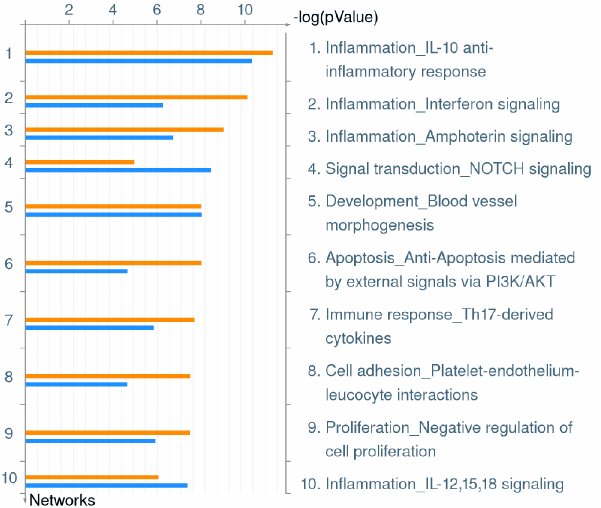
Figure 2. Top 10 Process Networks up-regulated in hMDMs upon infection by L. pneumophila . Meta- ankB mutant-infected hMDMs at 8 h post-infe- ankB mutant-infected